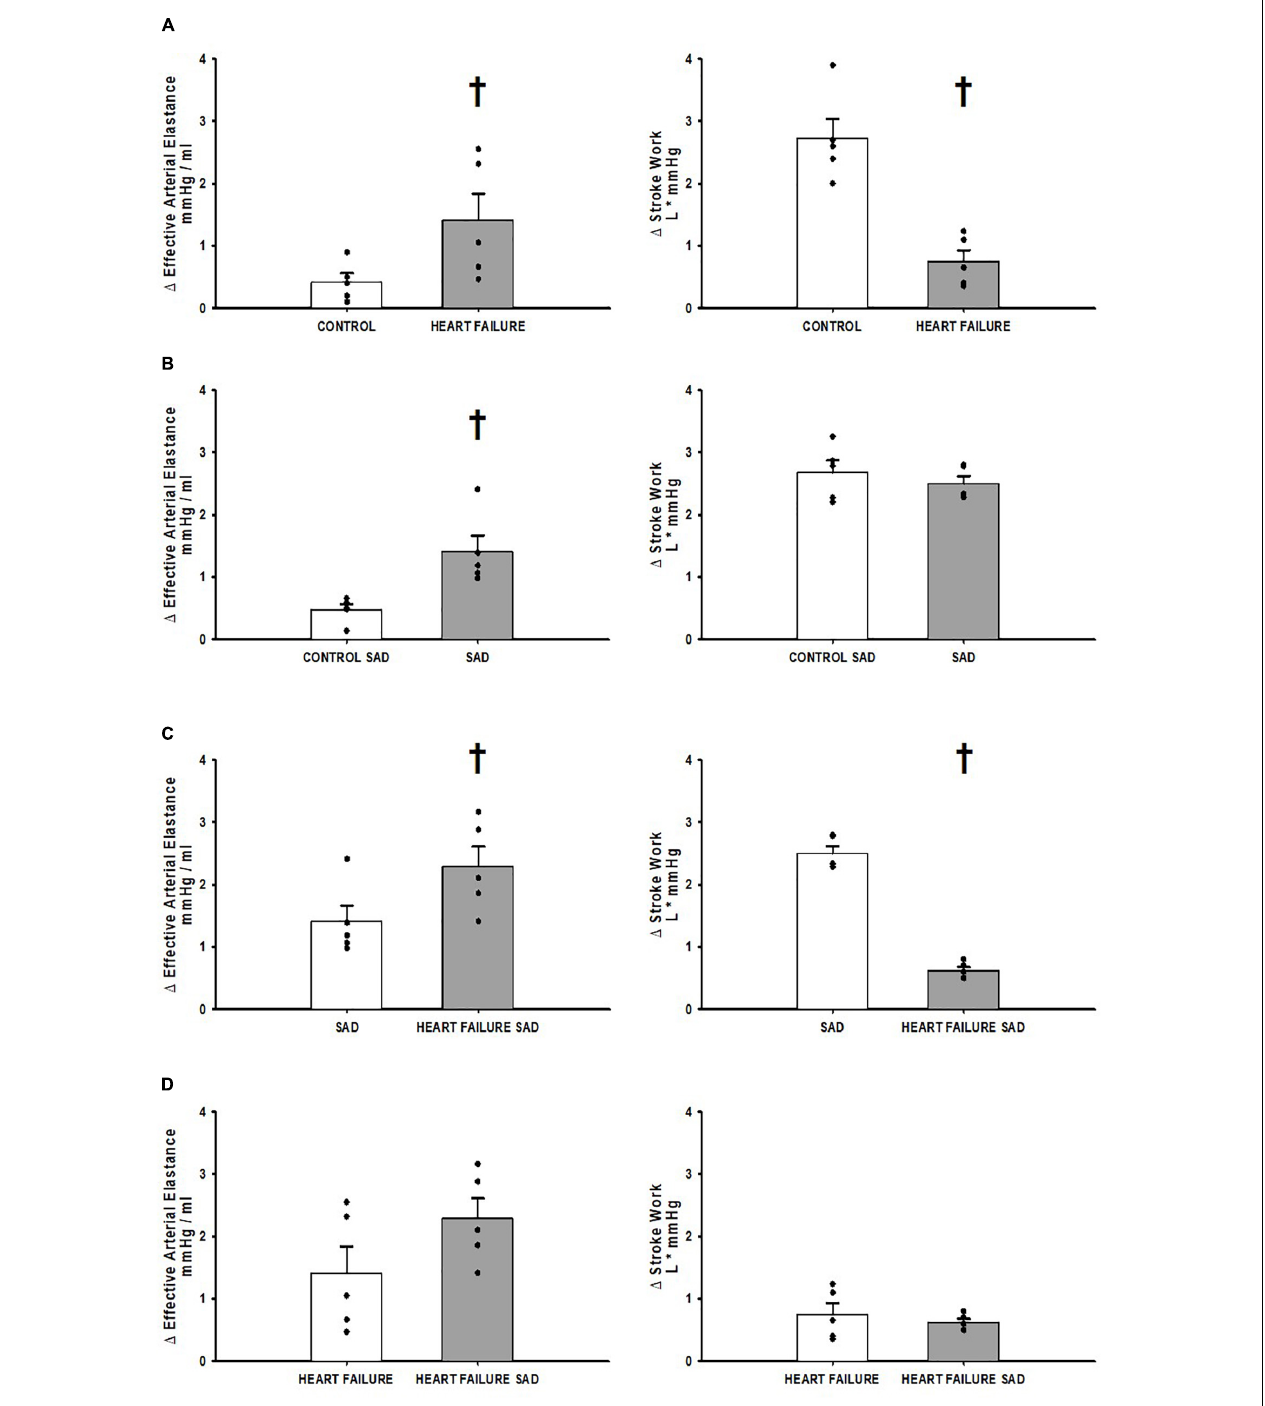
FIGURE 4 | (A) The relative change in Effective Arterial Elastance and Stroke Work in the transition from exercise to exercise with muscle metaboreflex activation before (white) and after induction of heart failure (gray) in the Control group . (B) The relative change in Effective Arterial Elastance and Stroke Work in the transition from exercise to exercise with muscle metaboreflex activation before (white) and after SAD (gray) in the SAD group . (C) The relative change in Effective Arterial Elastance and Stroke Work in the transition from exercise to exercise with muscle metaboreflex activation in normal animals with SAD (white) and after induction of heart failure post SAD (gray) in the SAD group . (D) The relative change in Effective Arterial Elastance and Stroke Work in the transition from exercise to exercise with muscle metaboreflex activation in heart failure animals from the Control group (white) and heart failure animals post SAD from the SAD group (gray). For all panels data are reported as means with standard error where data points are overlain on corresponding bar graphs. Statistical significance vs. the previous state as † where P < 0.05. An N = 5 was used for each bar graph in every panel.